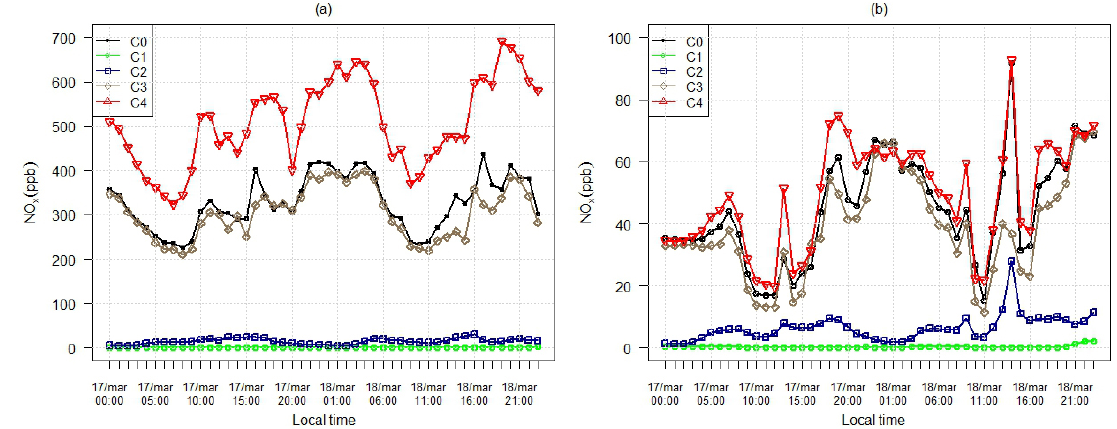
Figure 7. Temporal evaluation of NO x . Panel (a) represents the concentration within Manaus, while panel (b) refers to the point towards the pollution plume about 84km